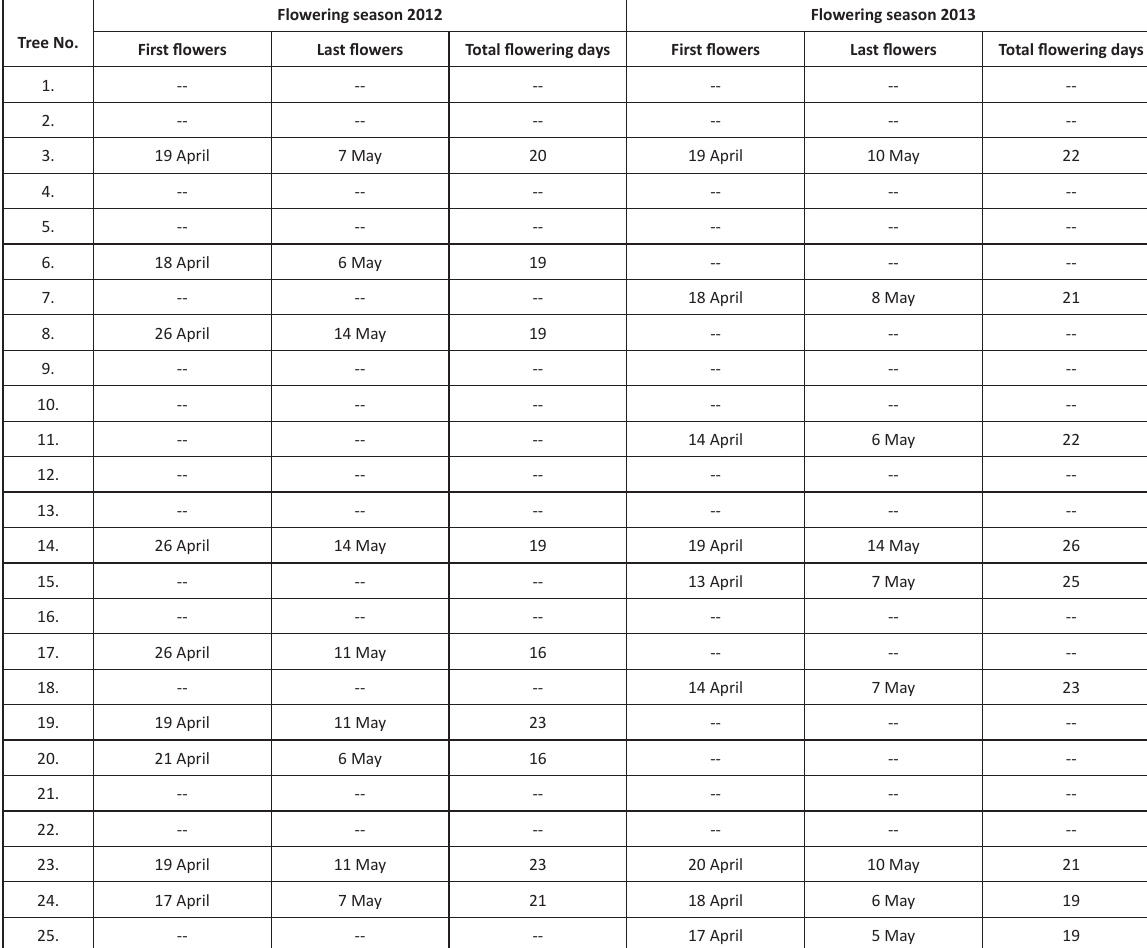
Table 1. Flowering phenology of Syzygium